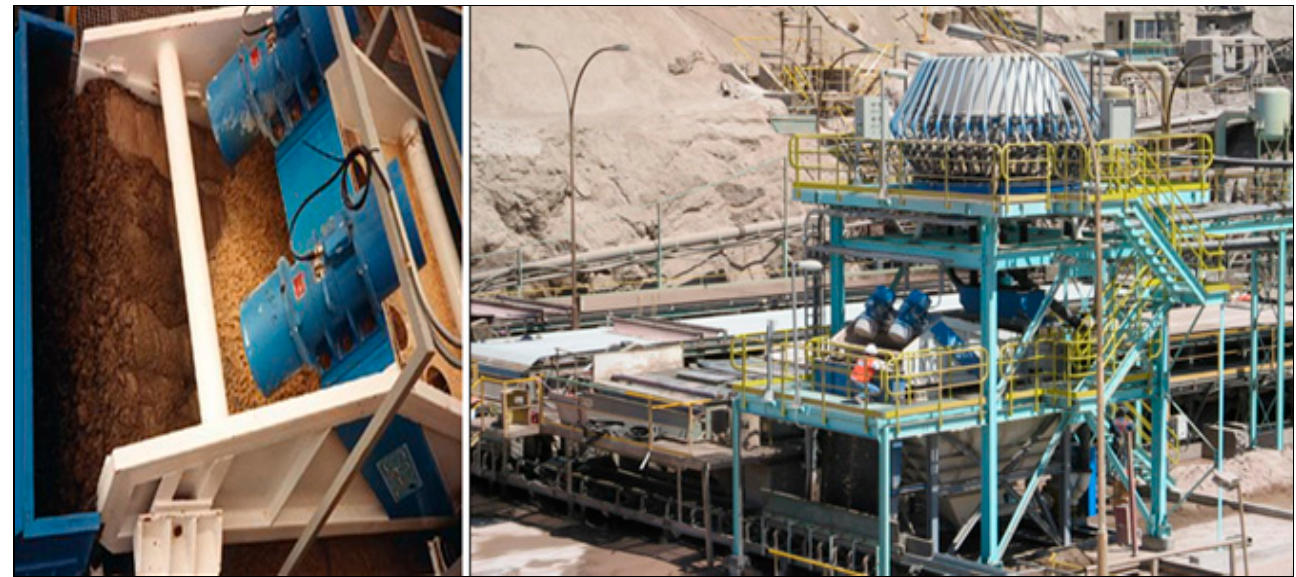
Figure 6. 1st Industrial Trial Phase of Mantos Blancos Tailings Plant 4056 mtpd: Hydrocyclone Cluster + 01 Horizontal Vibratory Dewatering Screen [40,41] .